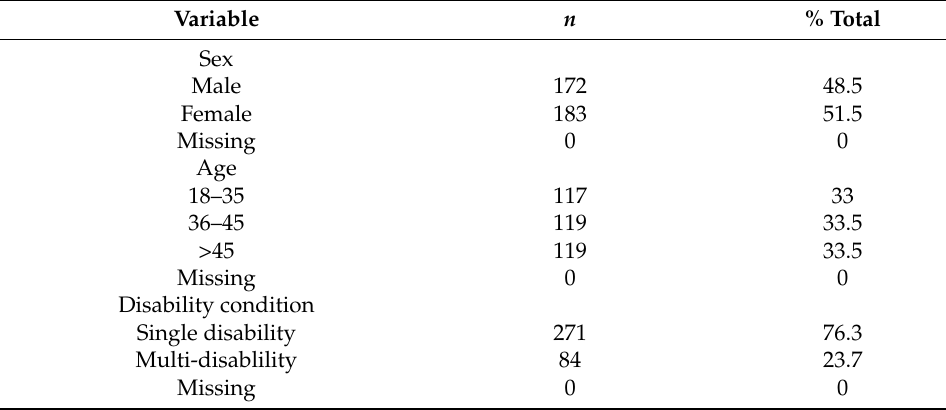
Table 1. Sociodemographic characteristics of the sample ( n = 355).